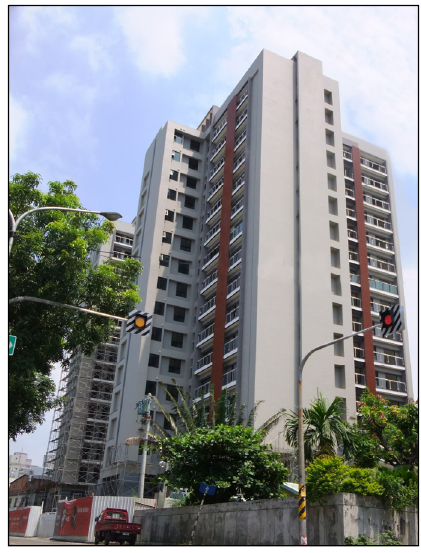
Figure 1. The Residential Building as the Case in this Study.